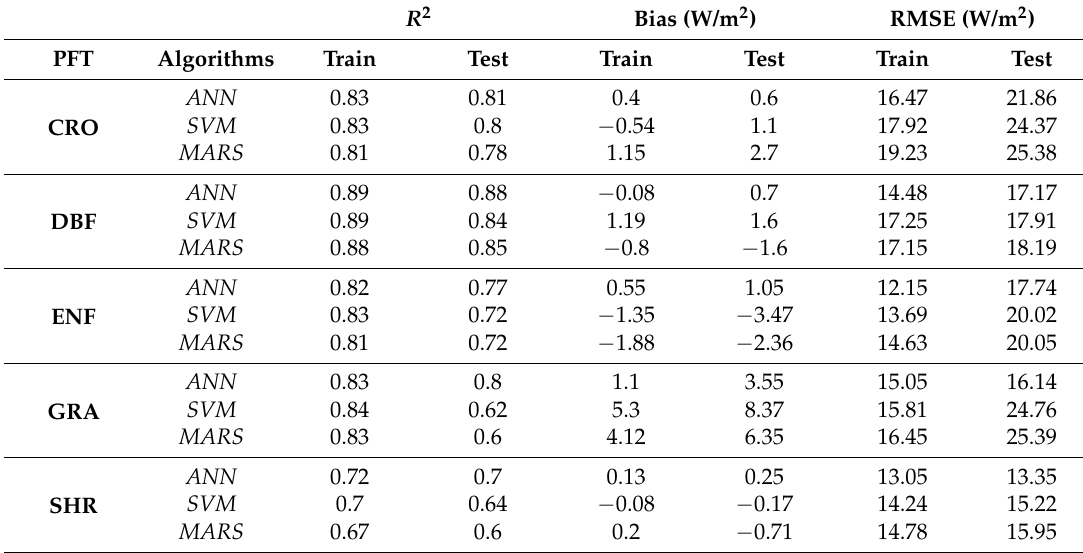
Table 1. Training and validation statistics for the different algorithms based on specific site. All of the coefficient of determination ( R 2 ) values are significant with a 99% confidence. R